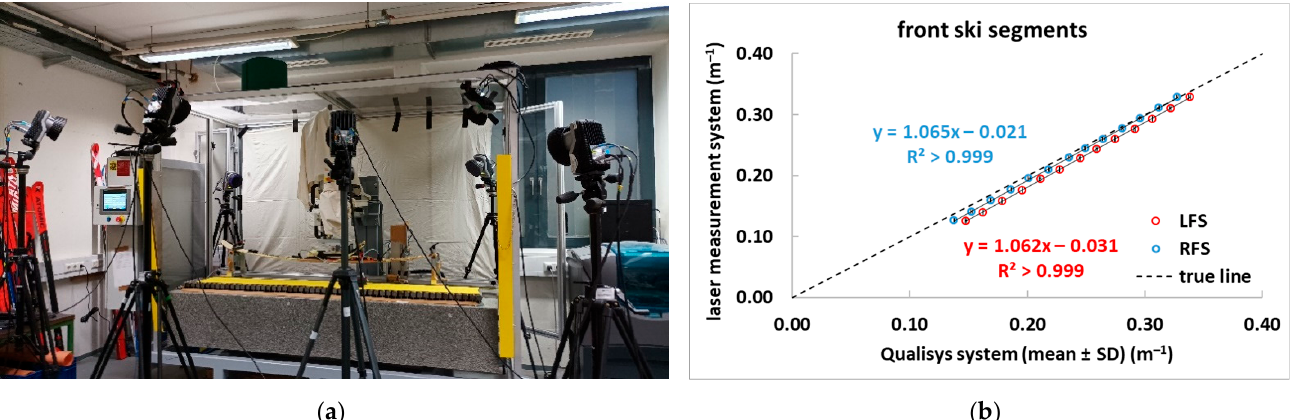
Figure A1. Construction drawing of the 3D printing template for standardized marker bases instrumentation on the ski. The material that was used was PLA NX2.